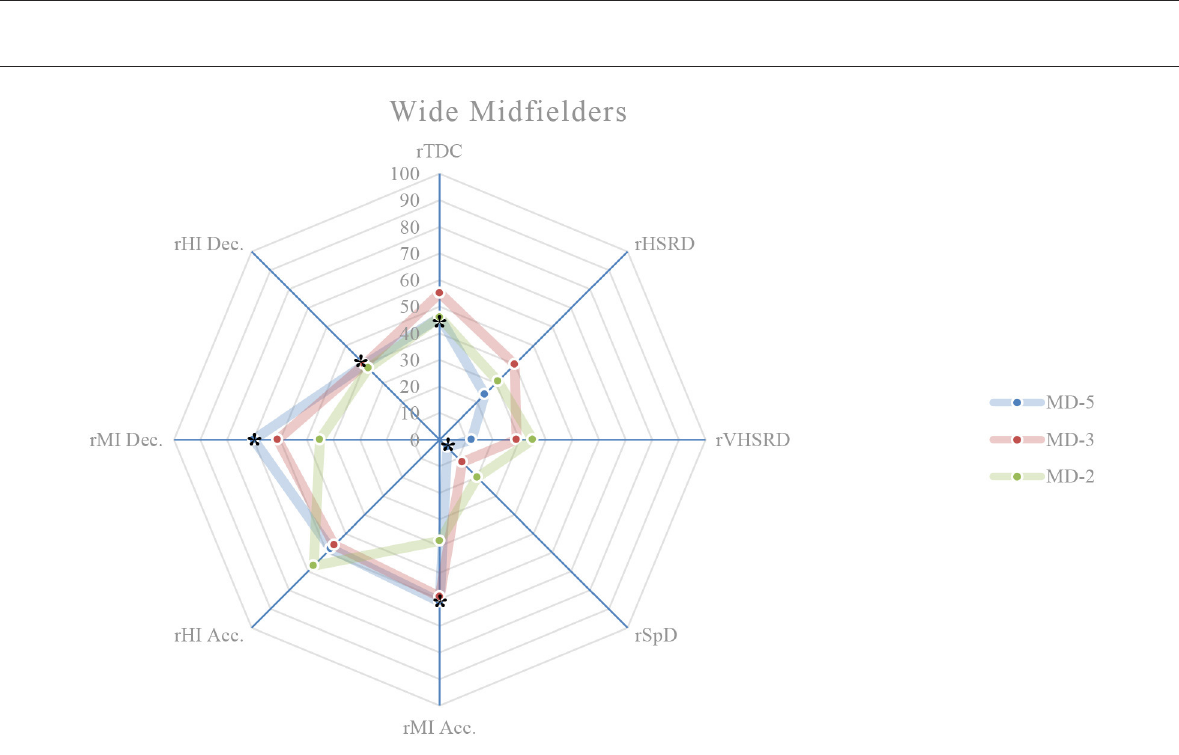
FIGURE4 Daily external load (based on MRef) of wide midfielders. *Location of the significant differences, p <